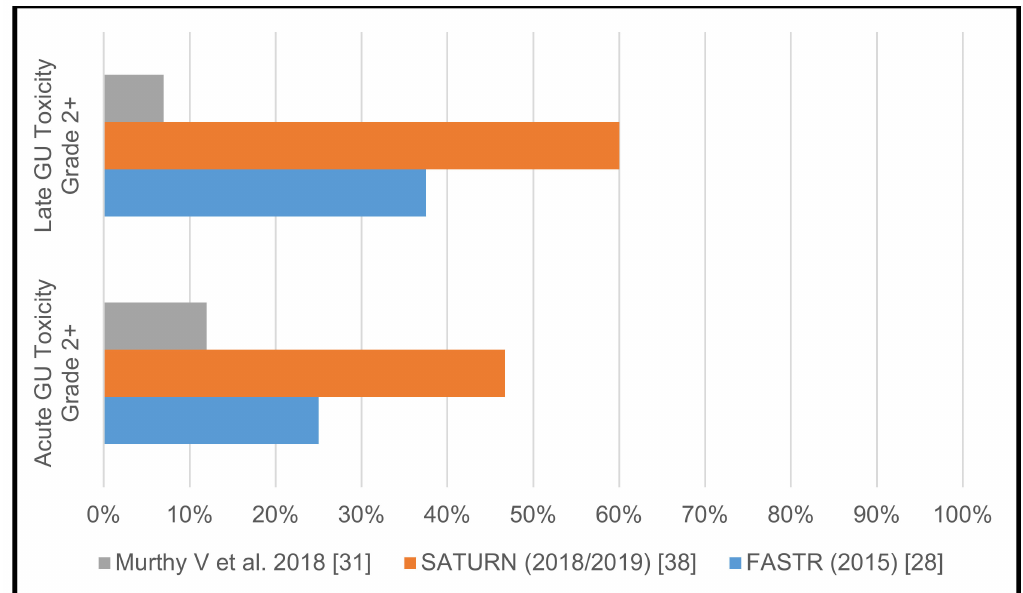
Figure 2. Acute and late genitourinary toxicity rates grades >/= 2 in studies with pelvic lymph node irradiation.